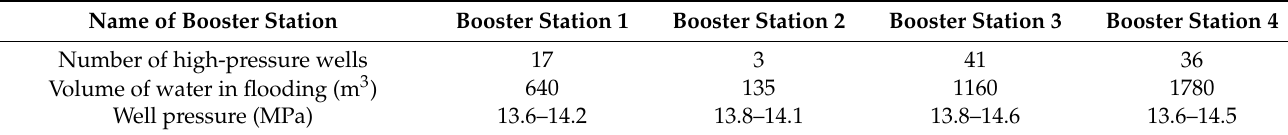
Table 4. Affiliation of high-pressure wells and booster stations.